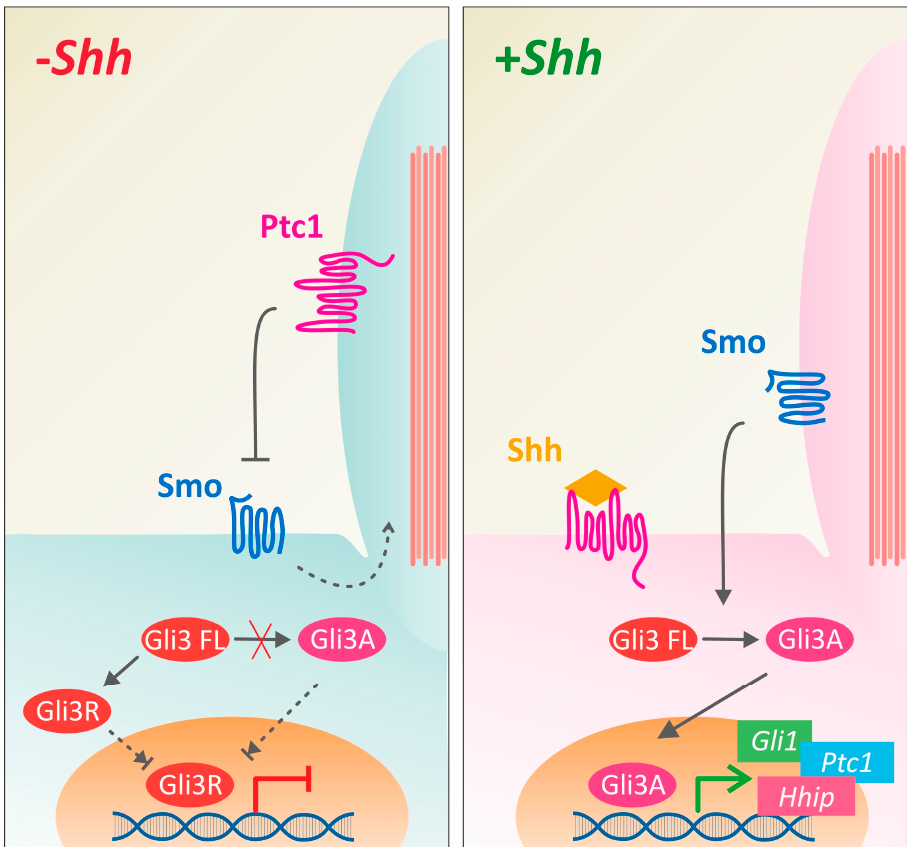
Figure 1. Canonical Shh signaling requires translocation of Smo into the primary cilium. Canonical Shh signaling depends on the de-repression of the G-protein-coupled receptor-like molecule Smoothend (Smo) by a mechanism involving the multiple-pass transmembrane receptor Patched1 (Ptc1). In the absence of Shh, Ptc1 represses Smo activity by preventing its translocation to the cilium. Shh binding to Ptc1 relieves this repression, allowing Smo to translocate to the primary cilium, where it activates intracellular signaling pathways. This activation of Smo culminates in transcriptional activity, via its regulation of Gli transcription factors that can activate or repress Shh target genes. Gli1 is always an activator of gene expression, whereas Gli2 and Gli3 (Gli3FL) need to be processed from a repressor (Gli3R) to an activator form (Gli3A) in a Smo-dependent manner.